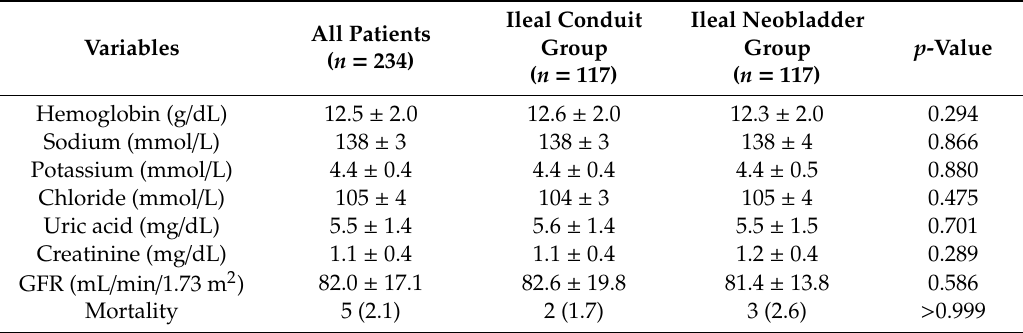
Table 3. One-year postoperative data after propensity score